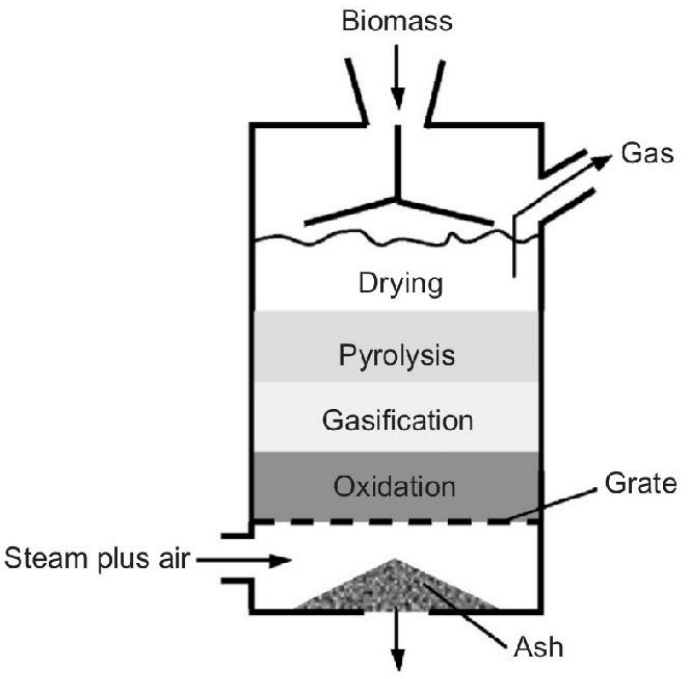
Figure 4. Fixed bed gasifier